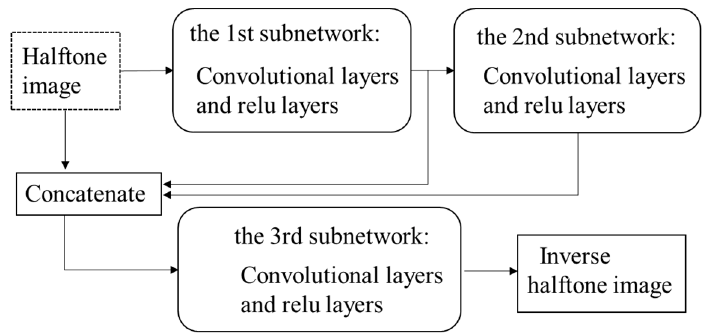
Figure 7. The network architecture in reference [19].